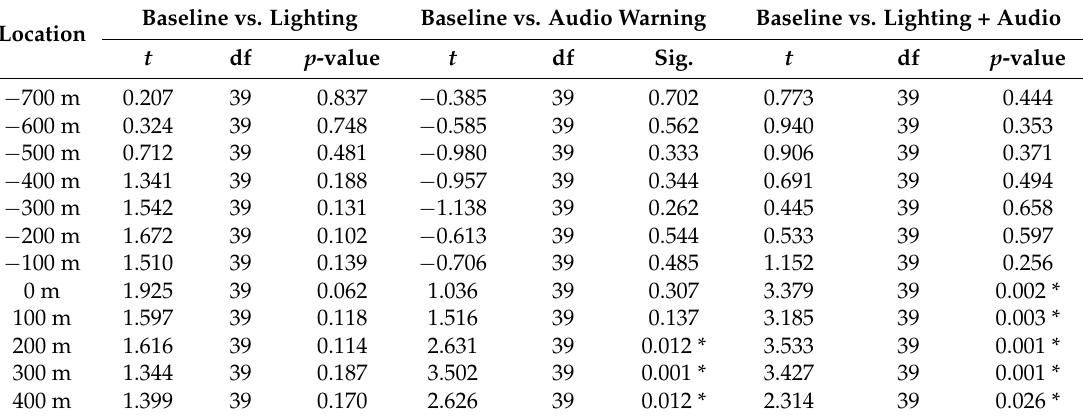
Table 2. The paired t -test results for operating speed at each